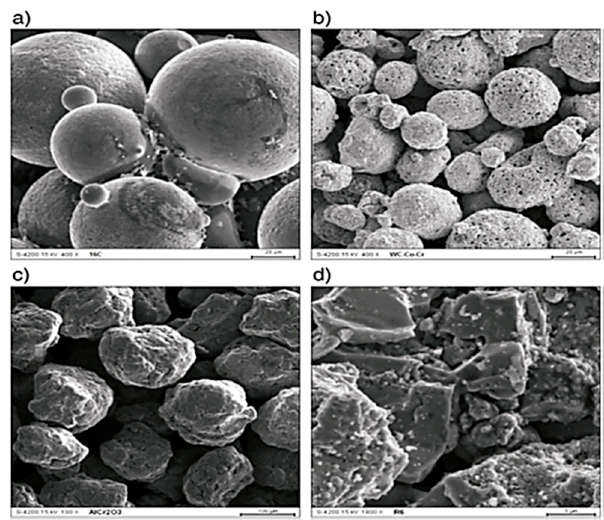
Figure 7. Titanium Carbide coating on austenitic steel produced by the way of: ( a ) spraying, ( b ) agglomerating and sintering, ( c ) mechanical alloying, ( d ) high temperature synthesis (Szymanski et al., 2014).